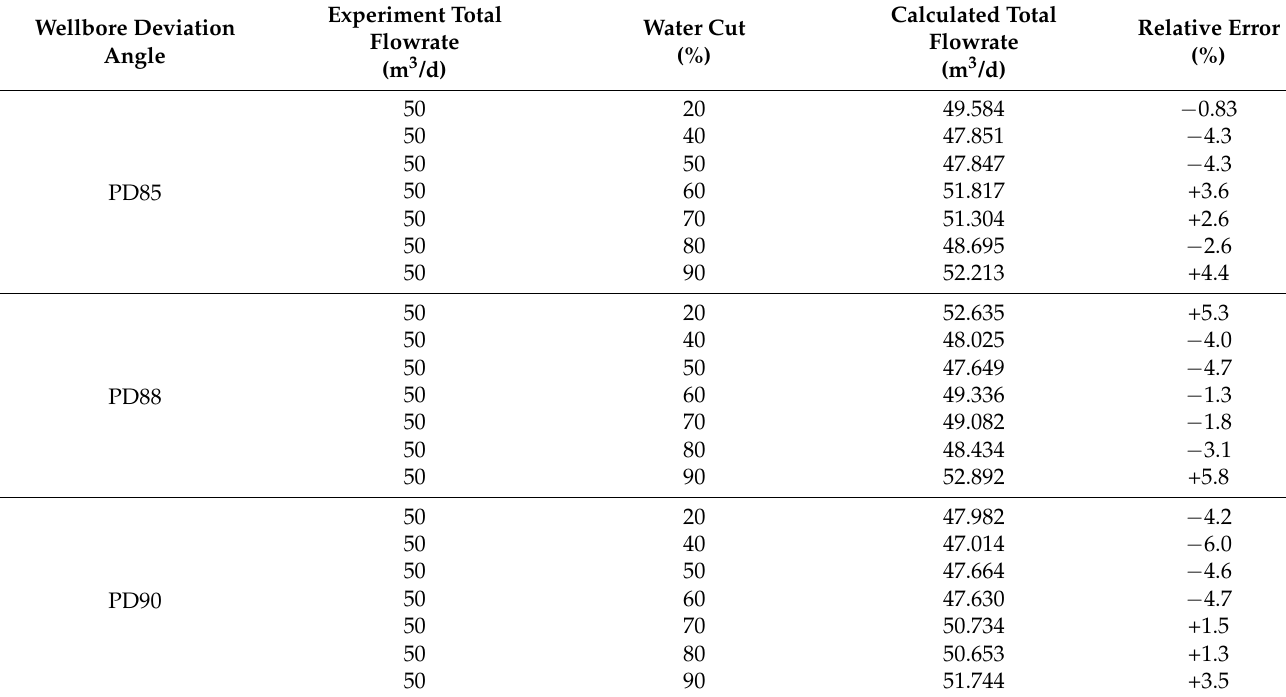
Table 3. Comparison between experimental and model-calculated total flowrate. Wellbore